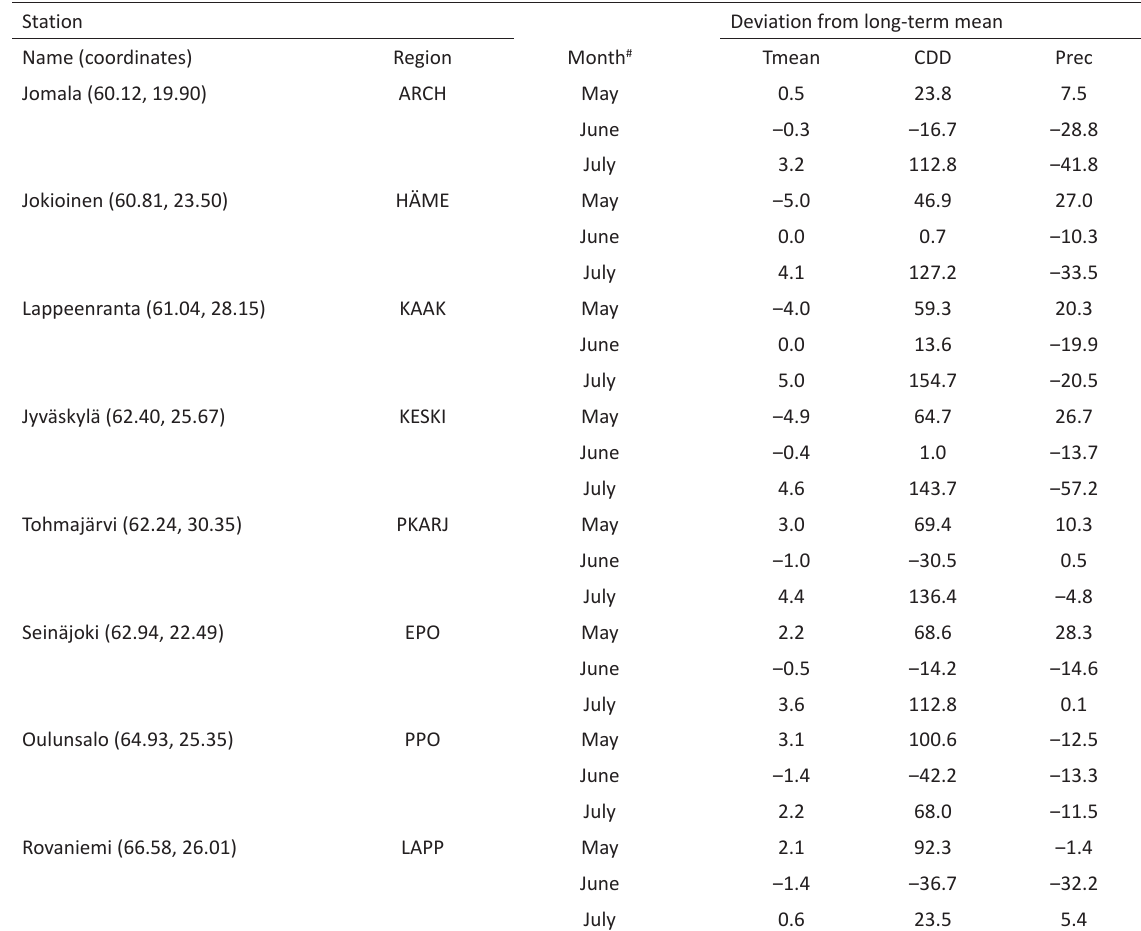
Table 3. Deviation of May, June and July mean temperature (Tmean, °C), cumulated degree days (CDD, °C) and accumulated precipitation (Prec, mm) from long-term mean (1981‒2010) in eight meteorological stations of Finland in 2010. See regions in Table 2 and Figure 1. Data from Finnish Meteorological Institute. Station Deviation from long-term